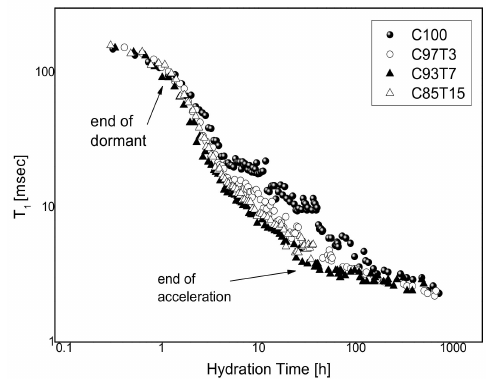
Figure 6. 1 H-T 1 NMR measurements for all four samples versus hydration